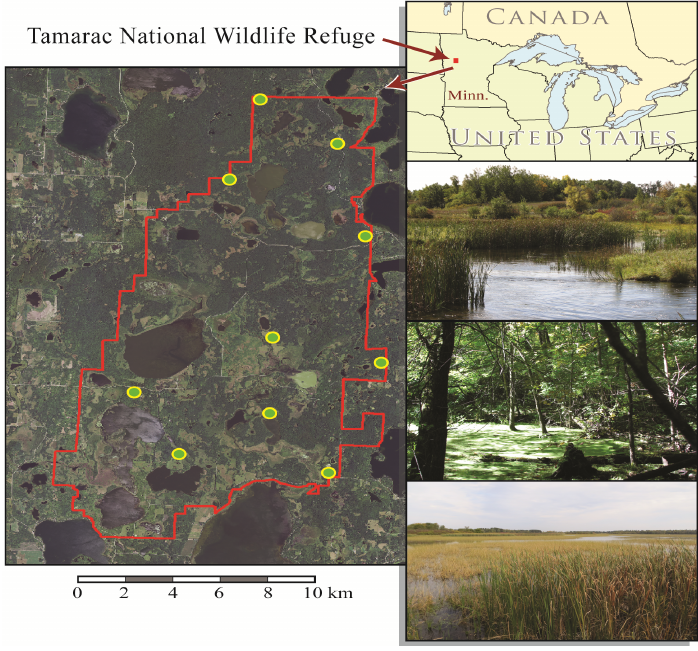
Figure 1. Location and example photos of the wetland-rich landscape of the Tamarac National Wildlife Refuge in Minnesota, USA. Filled circles indicate distribution of wetlands monitored in situ